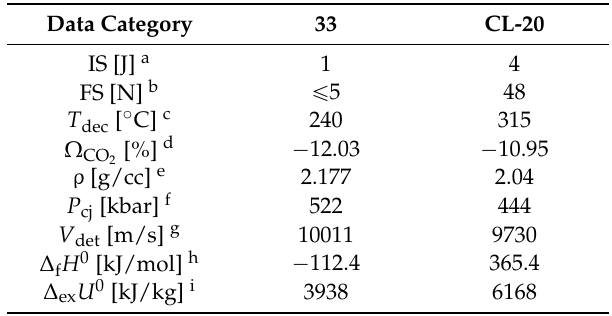
Table 4. Sensitivities and performance of the dipotassium salt of 1,5-Dinitramino tetrazole (33) and